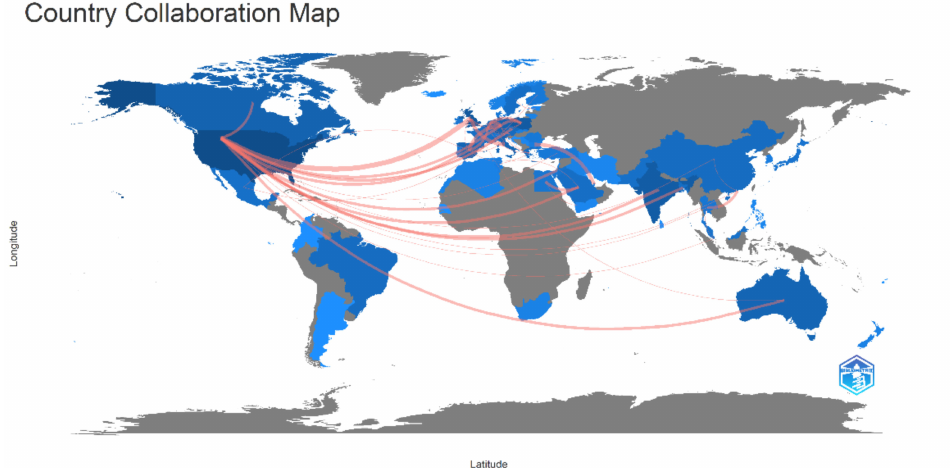
Figure 14. Map of collaboration among countries (this map was generated by Biblioshiny).